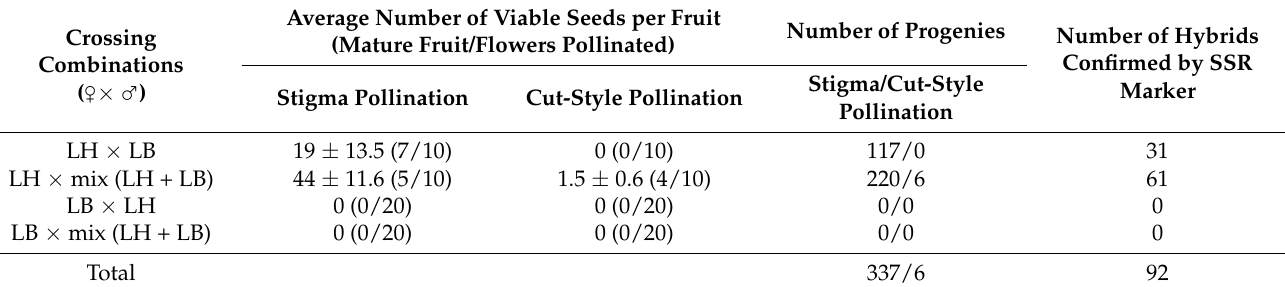
Table 1. Summary of interspecific crossing between L. hansonii and L. brownii var. colchesteri.